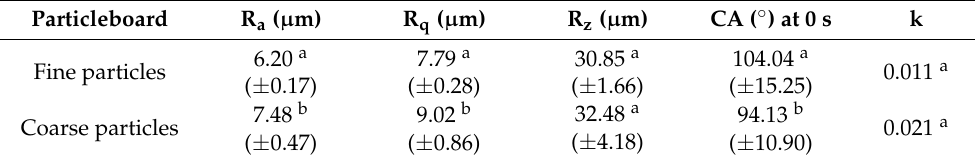
Table 3. Average surface roughness and contact angles of D. asper particleboards.